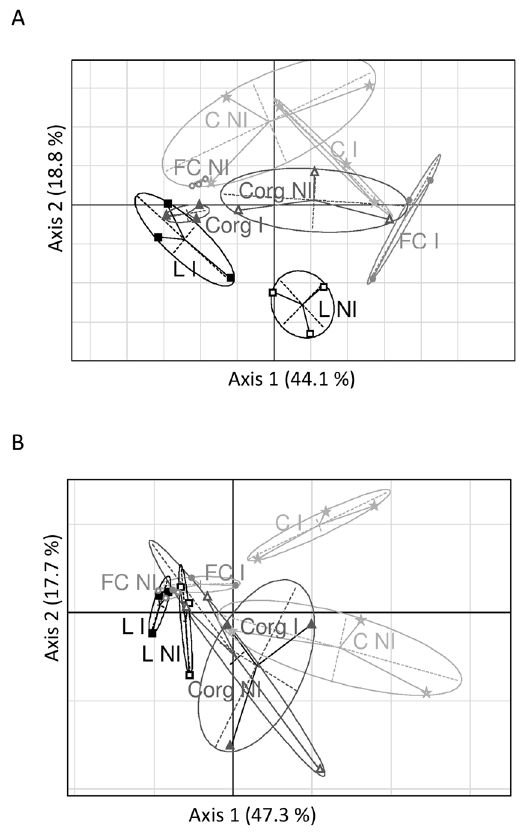
Figure 4. Partial least squares discriminant analysis (PLS-DA) of leaf ( A ) and root ( B ) metabolomes. Analyzed plants originated from the different fields (LC, circles; L, squares; C, stars and Corg, triangles; also distinguished by different shades of grey) and were either mock-inoculated (empty symbols) or inoculated with A . lipoferum CRT1 (full-colored